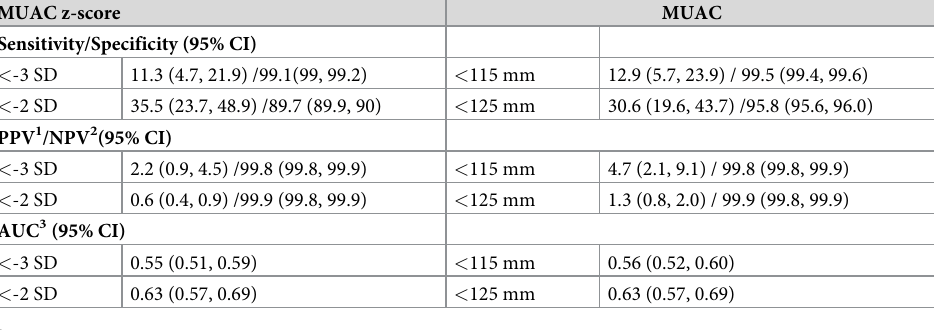
Table 3. Diagnostic probability of mortality by MUAC z-scores and MUAC categories in children aged 6–59 months.